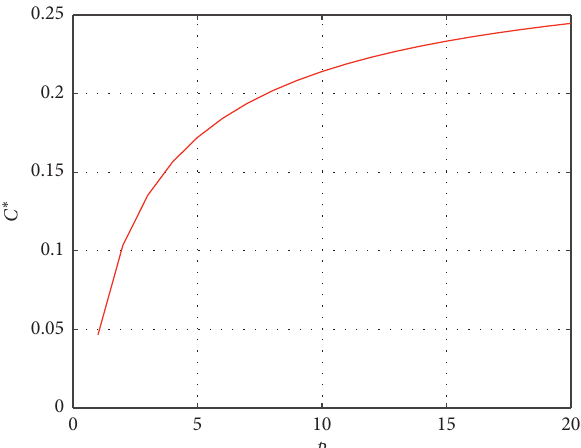
Figure 18: Effect of retail price p on the optimal inventory cost C ∗ under RMI mode with stochastic demand in the water supply chain.